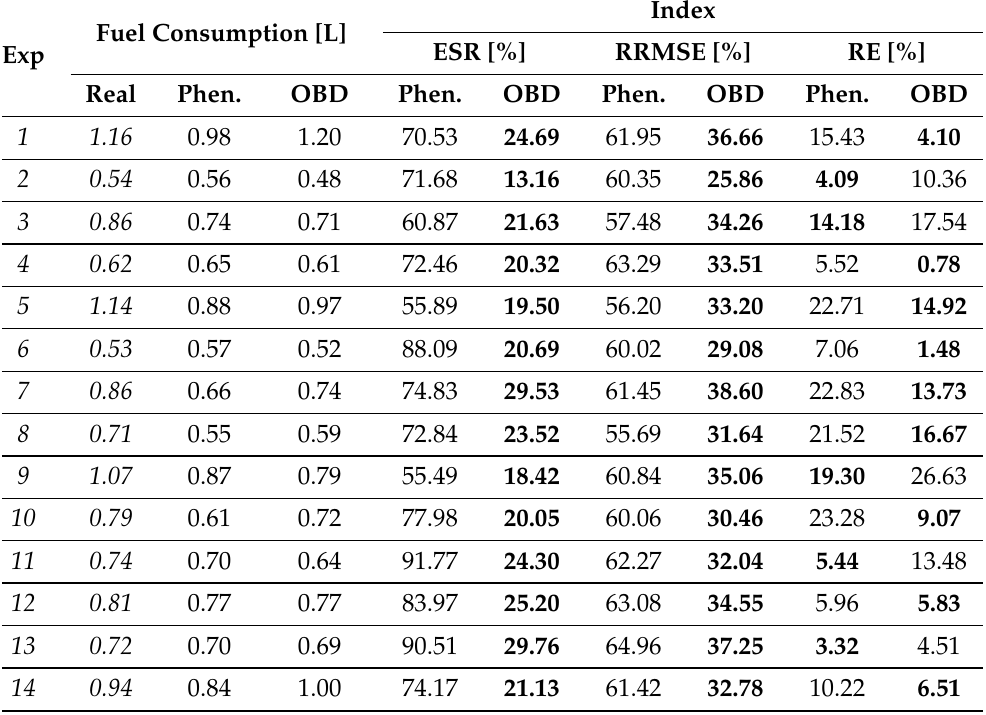
Table A2. Fuel consumption—experiments